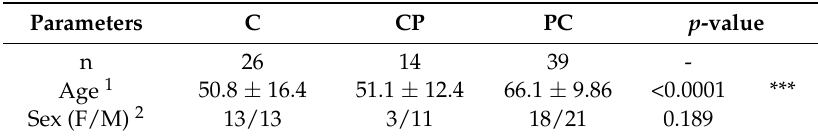
Table 1. Characteristics of the subjects involved in this study.